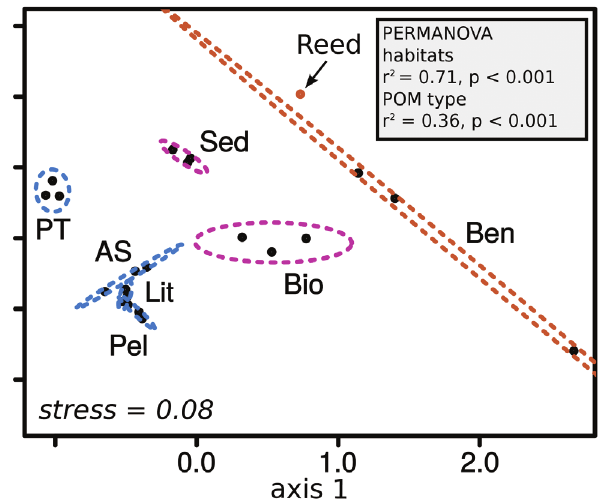
Figure 4. Habitat specificity of the fungal community in Lake Stechlin. NMDS plots based on the fun- gal OTU matrix (1027 OTUs). Ordination is based on Cao distances (Cao et al. 1997), which are insensi- tive to differences in sampling effort. Ellipses are based on standard deviations around habitat centroids (based on a confidence level of 0.95) and are coloured according to their POM type: FPOM (blue), MIX (magenta), CPOM (brown). Habitat codes and POM categories are taken from Table